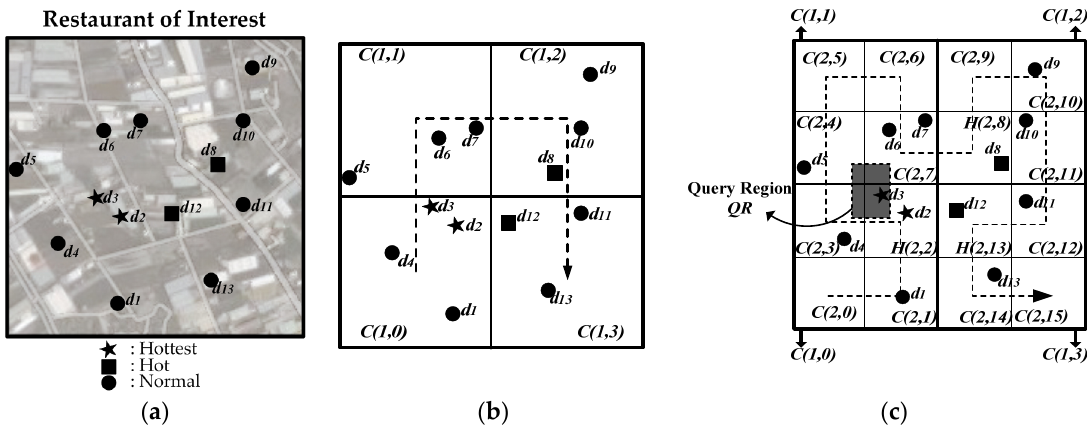
Figure 2. Spatial partitioning according to HC : ( a ) the original map; ( b ) spatial partitioning at Level 1; ( c ) spatial partitioning at Level 2.